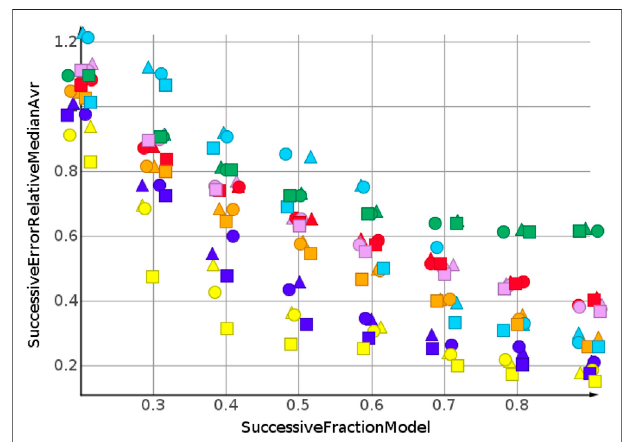
FIGURE 11 | cLogP, low to high sorted response values.